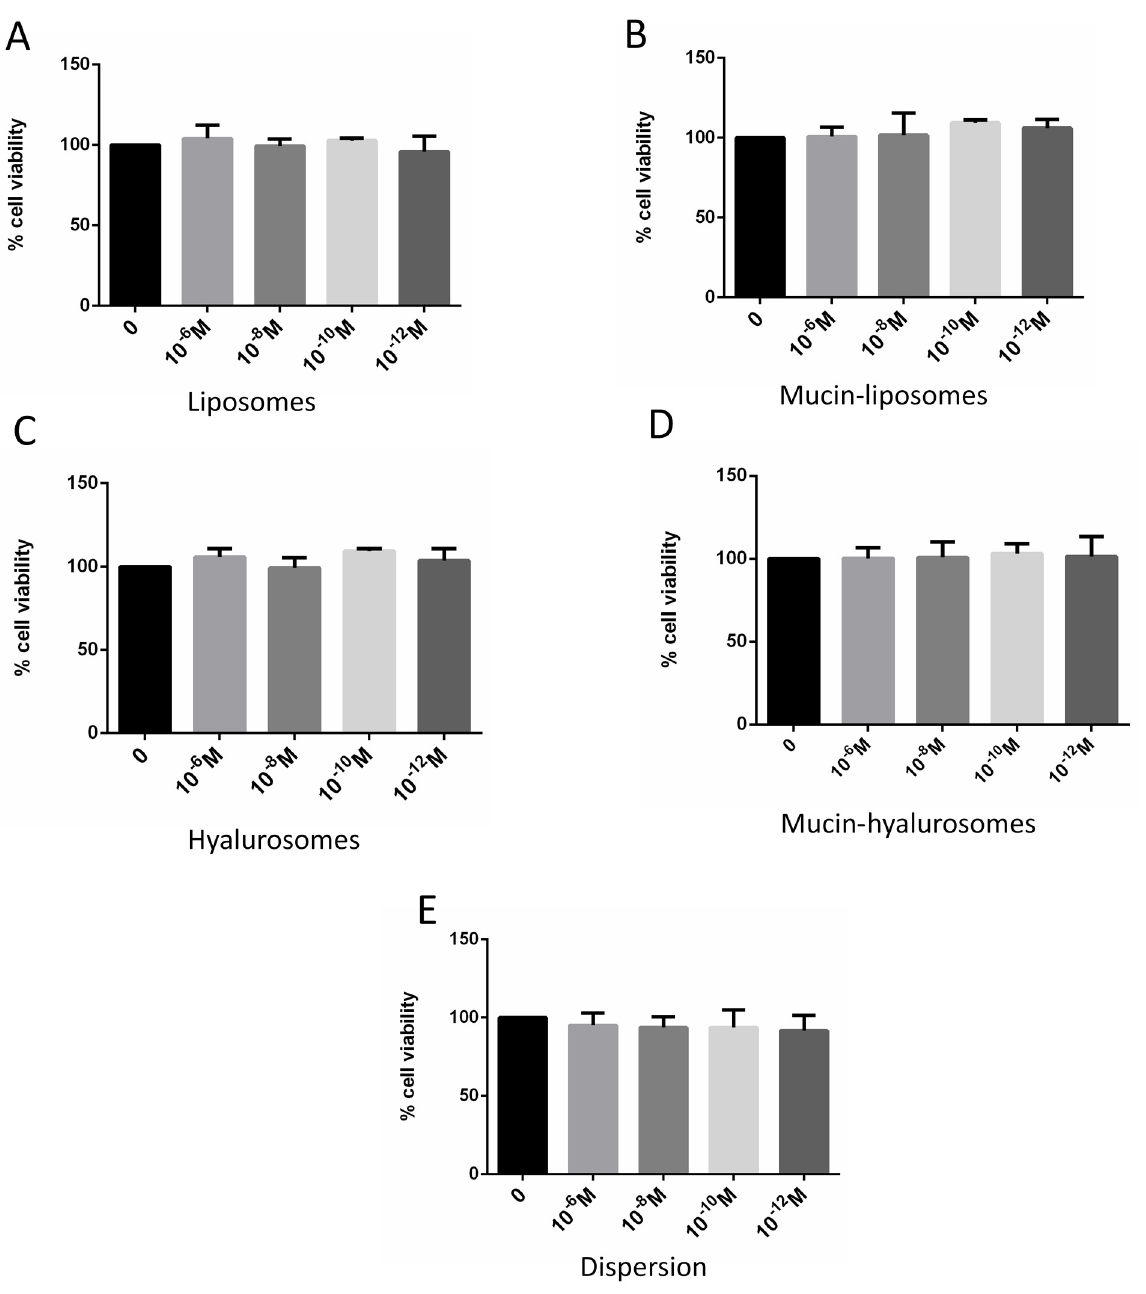
Figure 3. Cell viability of 16HBE incubated for 24 h with beclomethasone dipropionate in dispersion ( E ) or loaded in liposomes ( A ), Mucin-liposomes ( B ), Hyalurosomes ( C ) and Mucin-hyalurosomes ( D ). Mean values ± standard deviations (error bars) are reported ( n = 6).